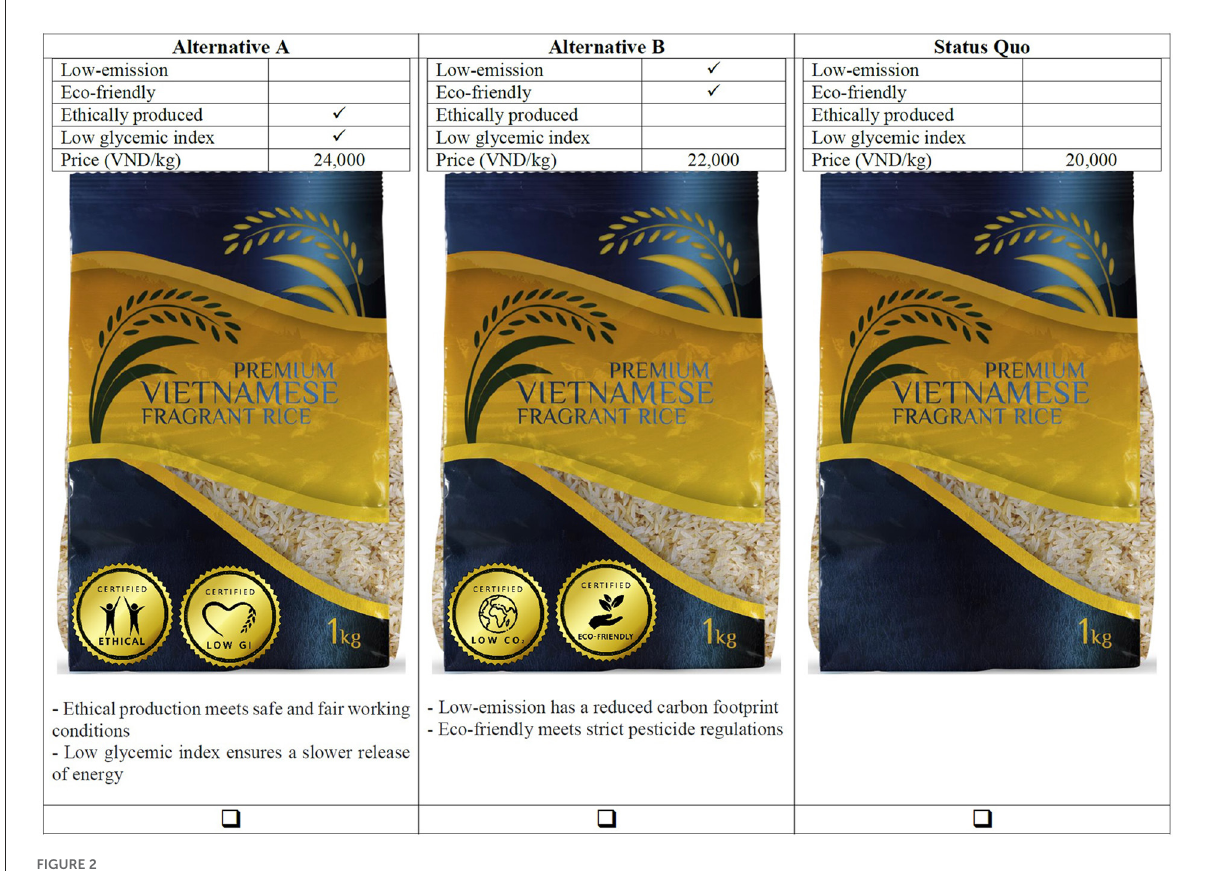
FIGURE2 Visual depiction of a choice card.